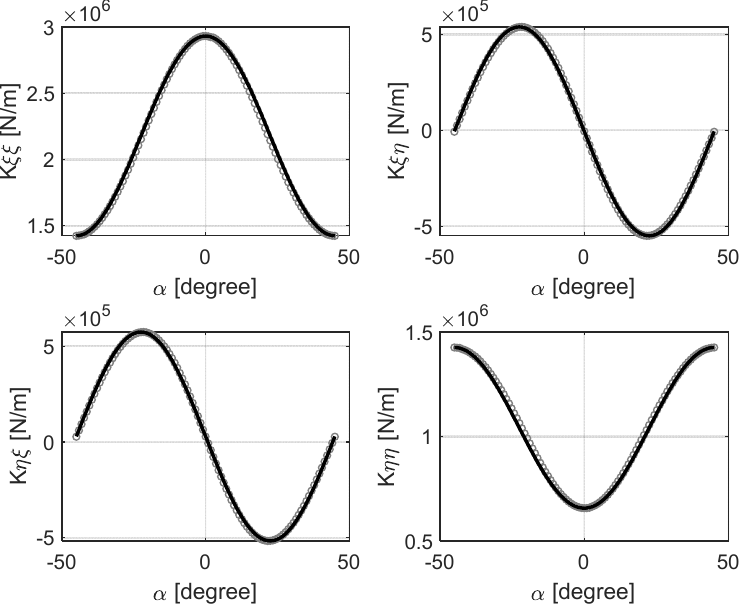
Figure 6. The local stiffness coefficients of the bearing at 0.5 of relative eccentricity and 1500 rpm. Circles (o) represent the stiffness coefficients calculated by RAPPID, whereas solid lines represent the stiffness coefficients calculated according to Equation (1).